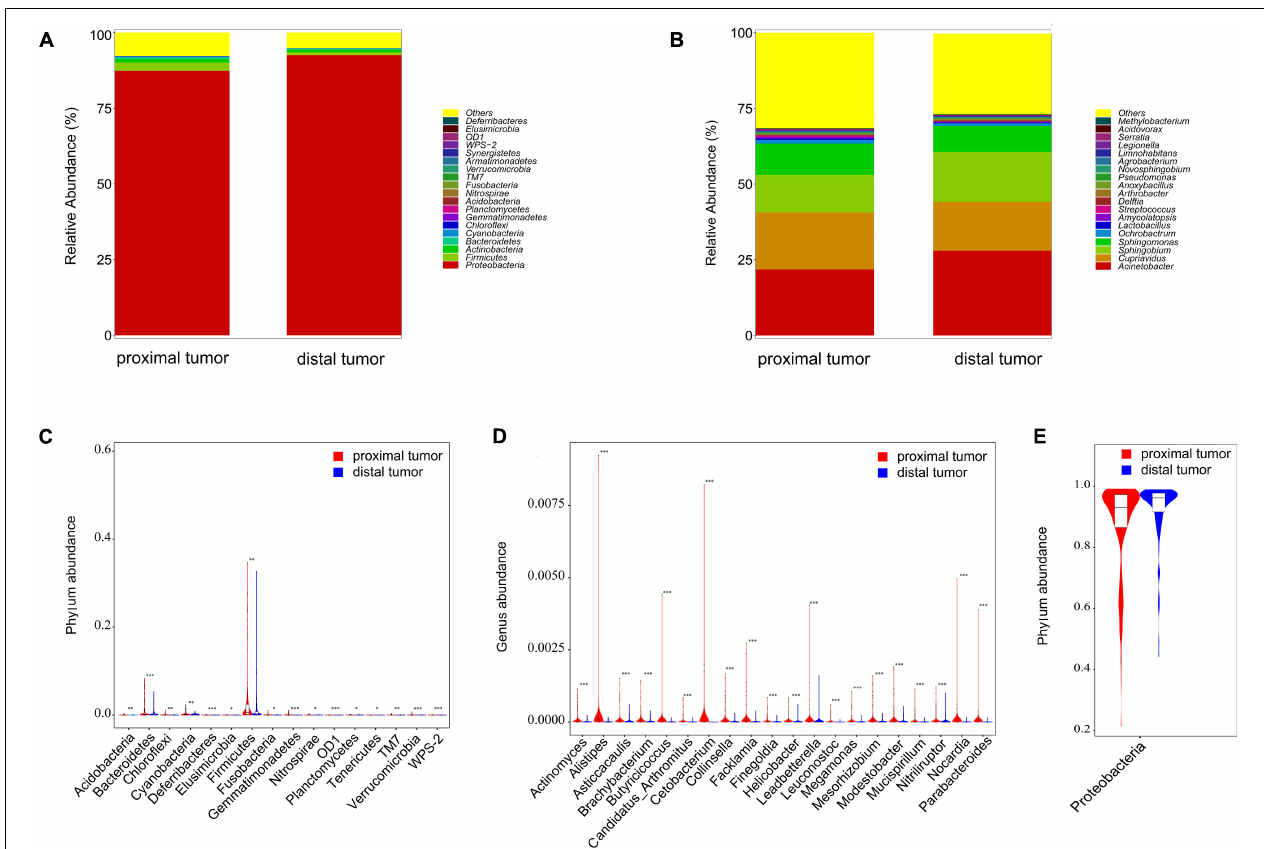
FIGURE 3 | Profiles of the microbial compositions and differential communities at the phylum and genus levels. Microbiota compositions at the phylum level (A) and genus level (B) between proximal and distal tumor tissues. The enriched microbial communities in proximal tumor tissues vs. distal tumor tissues, at the phylum level (C) and genus level (D) . The enriched microbial community in distal tumor tissues vs. proximal tumor tissues at the phylum level (E) . ∗ p < 0.05; ∗∗ p < 0.01; ∗∗∗ p <